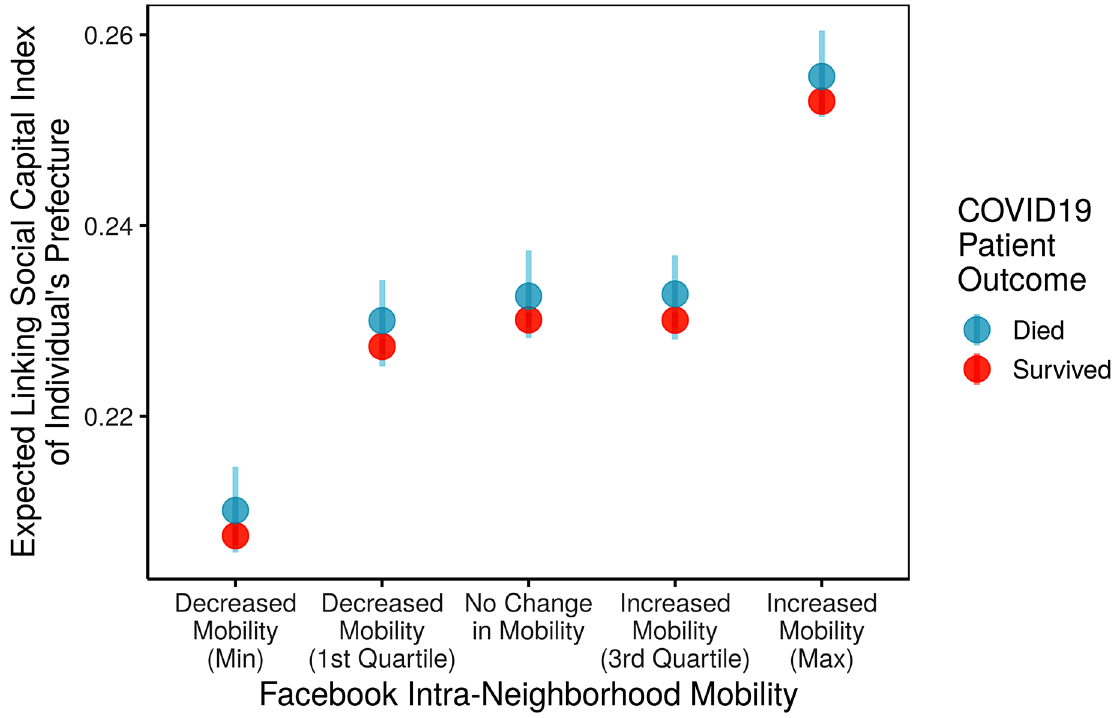
Figure 7. Higher linking social capital expected from individuals in high mobility